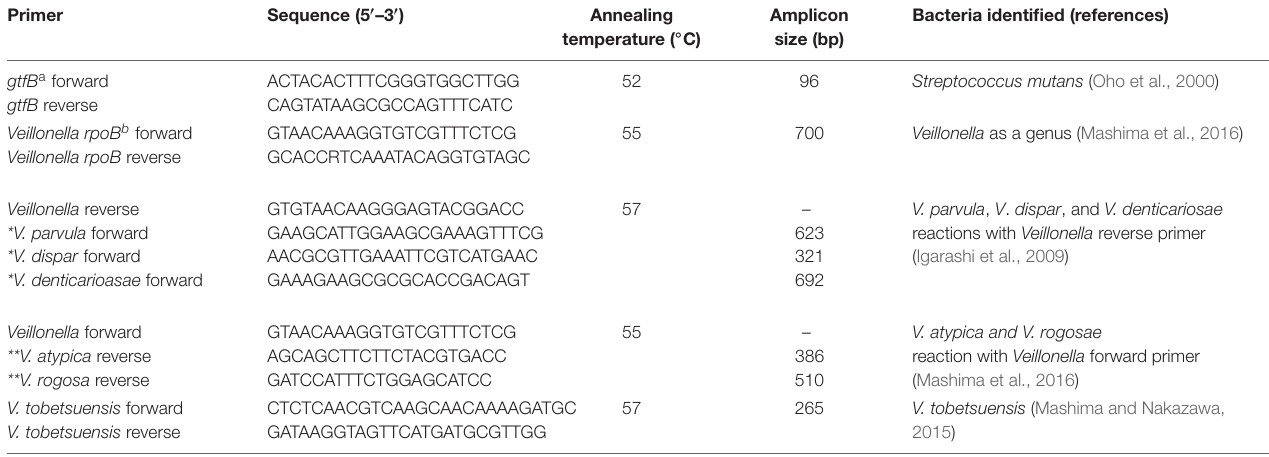
TABLE 1 | Primers used for molecular identification of Streptococcus mutans and Veillonella spp. Primer Sequence (5 (cid:48) –3 (cid:48) )